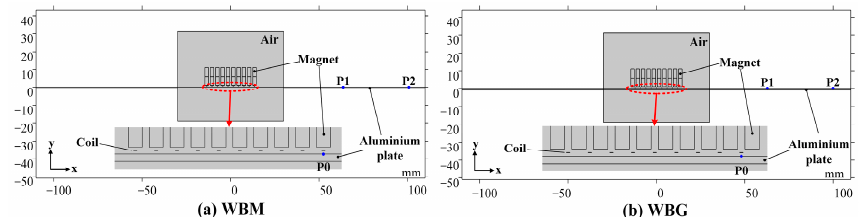
Figure 3. 2-D FE simulation models of the WBM and WBG EMAT. ( a ) WBM model, P0 (12, 0), P1 (60, 0) and P2 (100, 0). ( b ) WBG model, P0 (13.5, 0), P1 (60, 0) and P2 (100, 0). P0 is located on the sample surface and beneath the rightmost wires.